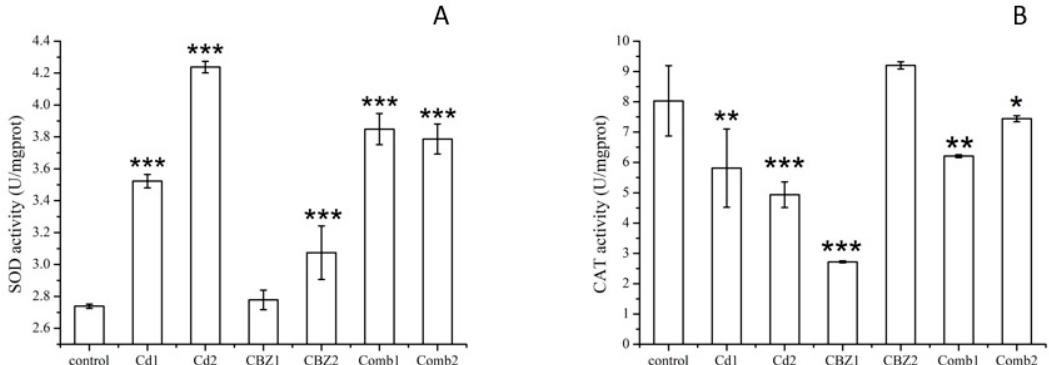
Figure 1. (A) Superoxide dismutase (SOD) activities and (B) the catalase (CAT) activities in female 138 zebrafish after ten days of exposure to cadmium (Cd), carbamazepine (CBZ), and Cd + CBZ. The 139 results of one-way ANOVA are indicated at the significance levels * p < 0.05, ** p < 0.01, and *** p < 0.001. 140